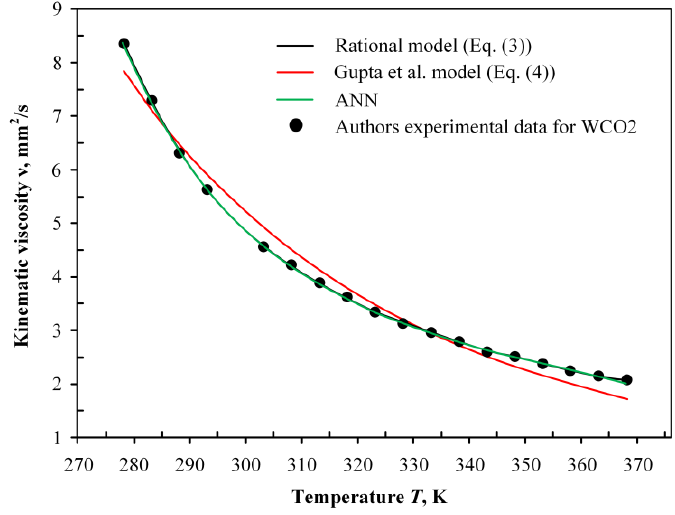
Fig. 2. Variation in kinematic viscosity of WCO2 vs.